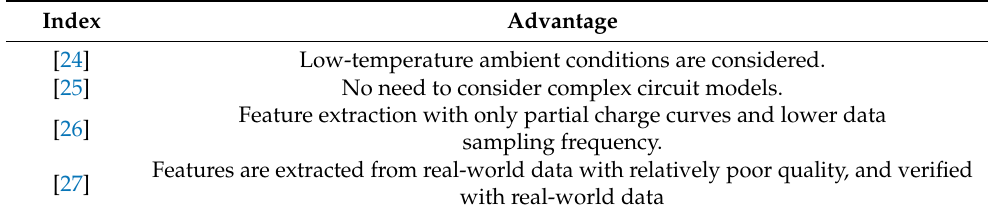
Table 1. The advantages of the proposed